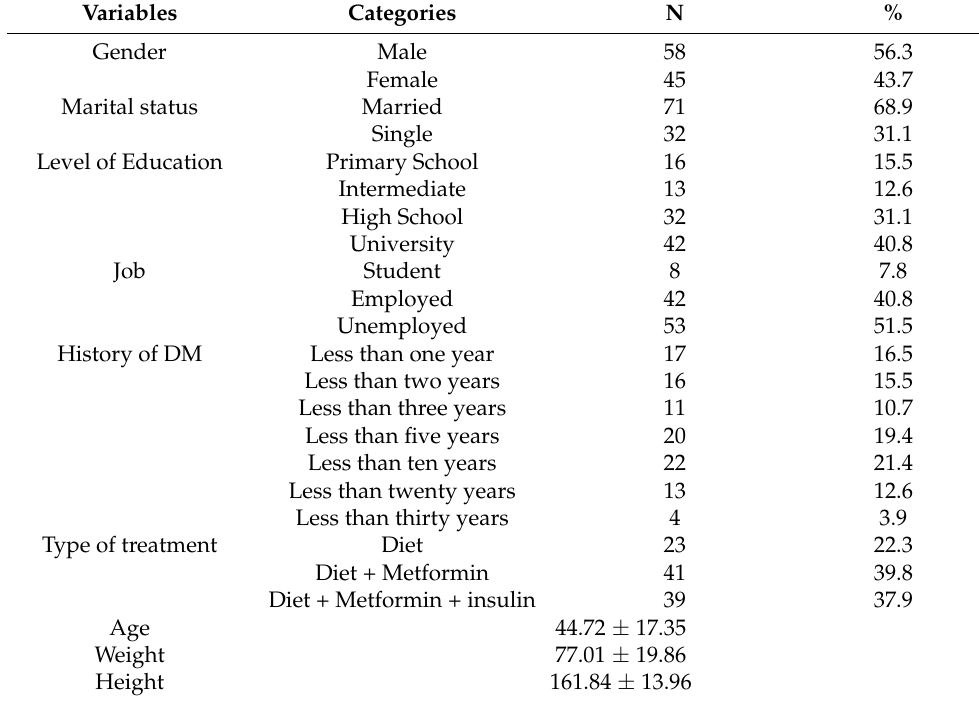
Table 1. Socio-demographic characteristics of